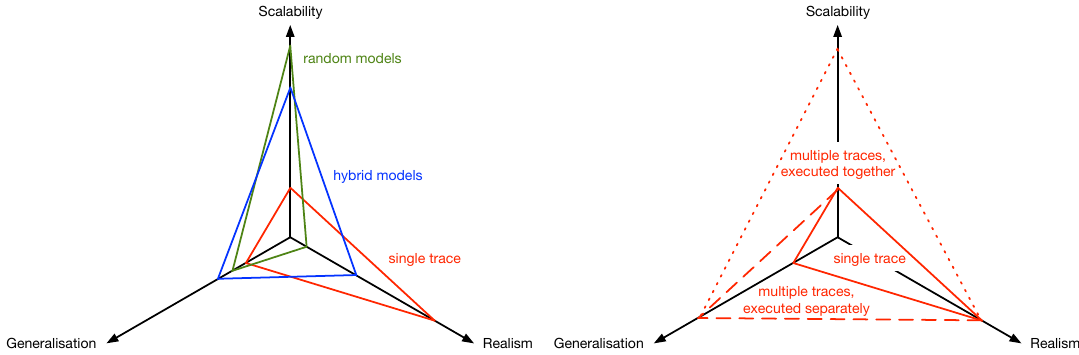
Figure 6. Properties of standard mobility models (left) and extension opportunities for trace-based models (right).